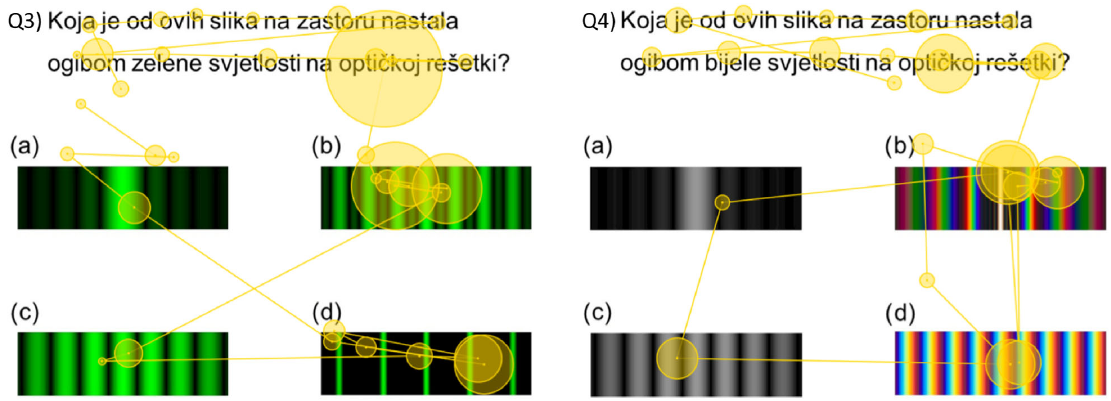
FIG. 1. Example of one participant ’ s scan path for questions Q3 and Q4. The centers of circles show positions of fixations (when the eyes remain relatively still) and the lines show saccades (rapid eye movements between fixations). The radii of circles are proportional to the duration of fixations. The four green patterns on the left were possible answers for questions Q1, Q2, and Q3, whereas four patterns on the right were possible answers for question